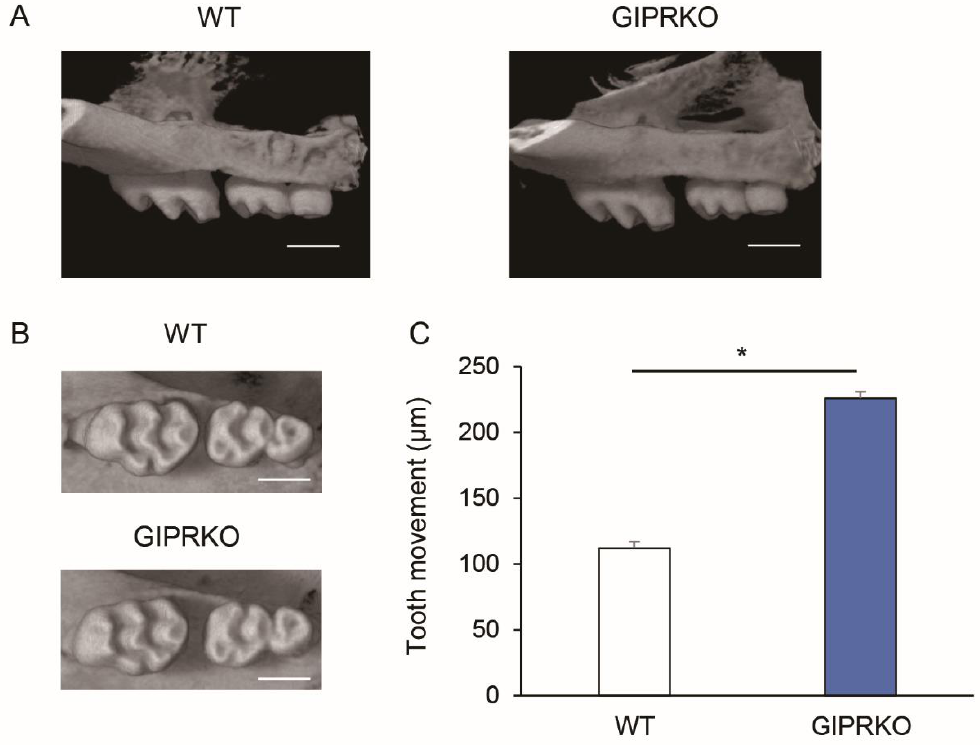
Figure 3. Orthodontic tooth movement in the WT and the GIPRKO. Comparison of µ CT images 14 days after orthodontic tooth movement. ( A ) Sagittal section and ( B ) horizontal section. Scale bar: 1.0 mm. ( C ) Average distance between M1 and M2 14 days after orthodontic tooth movement (* p < 0.05) (WT: n = 5, GIPRKO: n = 4).